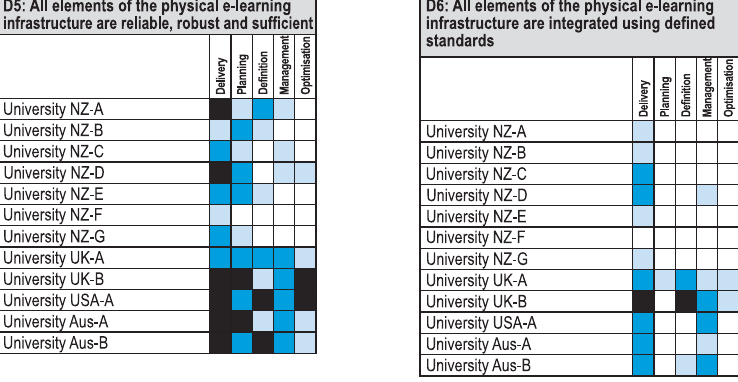
Figure 5. University process D5 and D6 capabilities (Marshall